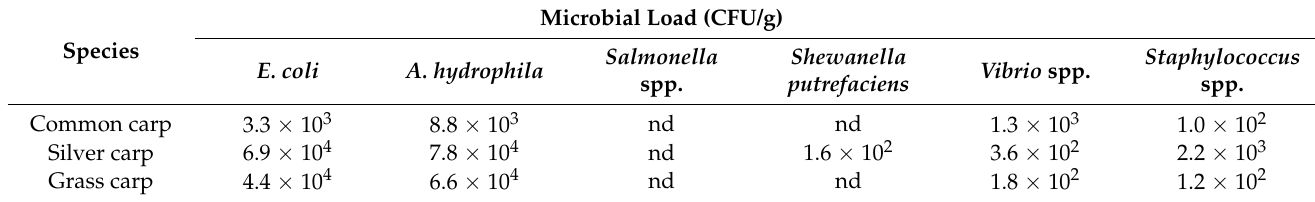
Table 1. Isolation and quantification of pathogenic bacteria from common carp, silver carp and grass carp samples ( n = 5).